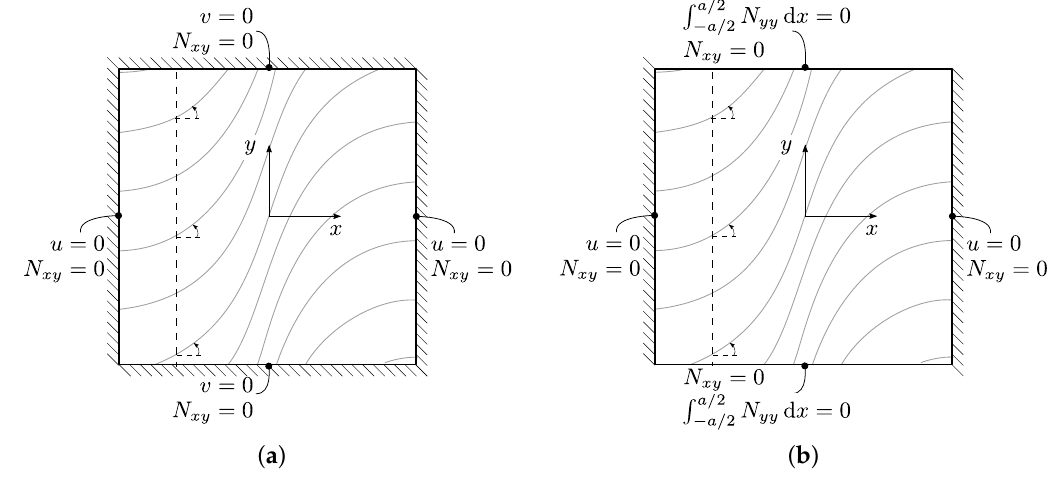
Figure 2. Pre-buckling boundary conditions for fiber variation along x : ( a ) Case-Tx1; ( b )